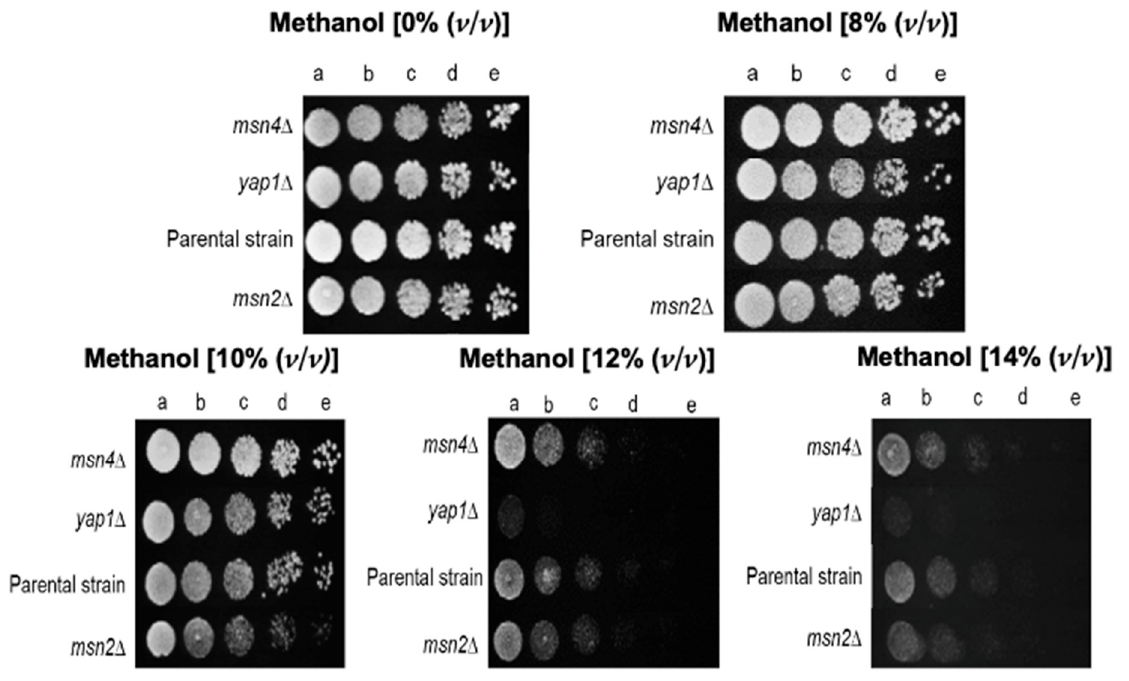
Figure 5. Susceptibility to methanol of the parental strain S. cerevisiae BY4741 and derived deletion mutants yap1 ∆ , msn4 ∆ , and msn2 ∆ by spot assays. Yeast cell suspensions used as inocula for spot assays were prepared using cells harvested in the exponential phase of growth (culture OD 600nm = 0.5 ± 0.05). Cell suspensions were diluted in sterile water to an OD 600nm = 0.25 ± 0.005 (a) and this solution was used to prepare 1:5 (b), 1:25 (c), 1:125 (d), and 1:625 (e) diluted suspensions. Susceptibility phenotypes were registered after 48 h of incubation at 35 °C.